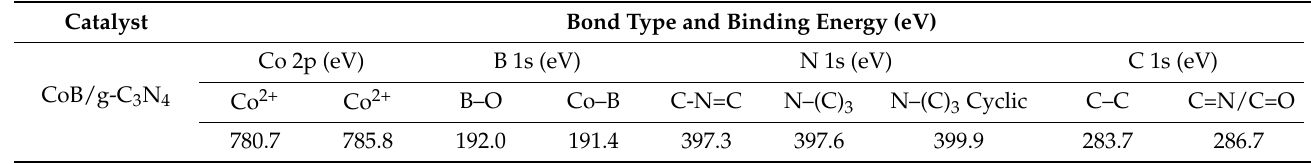
Table 1. XPS table of binding energy for C 1s, N 1s, Co 2p, and B 1s. Catalyst Bond Type and Binding Energy